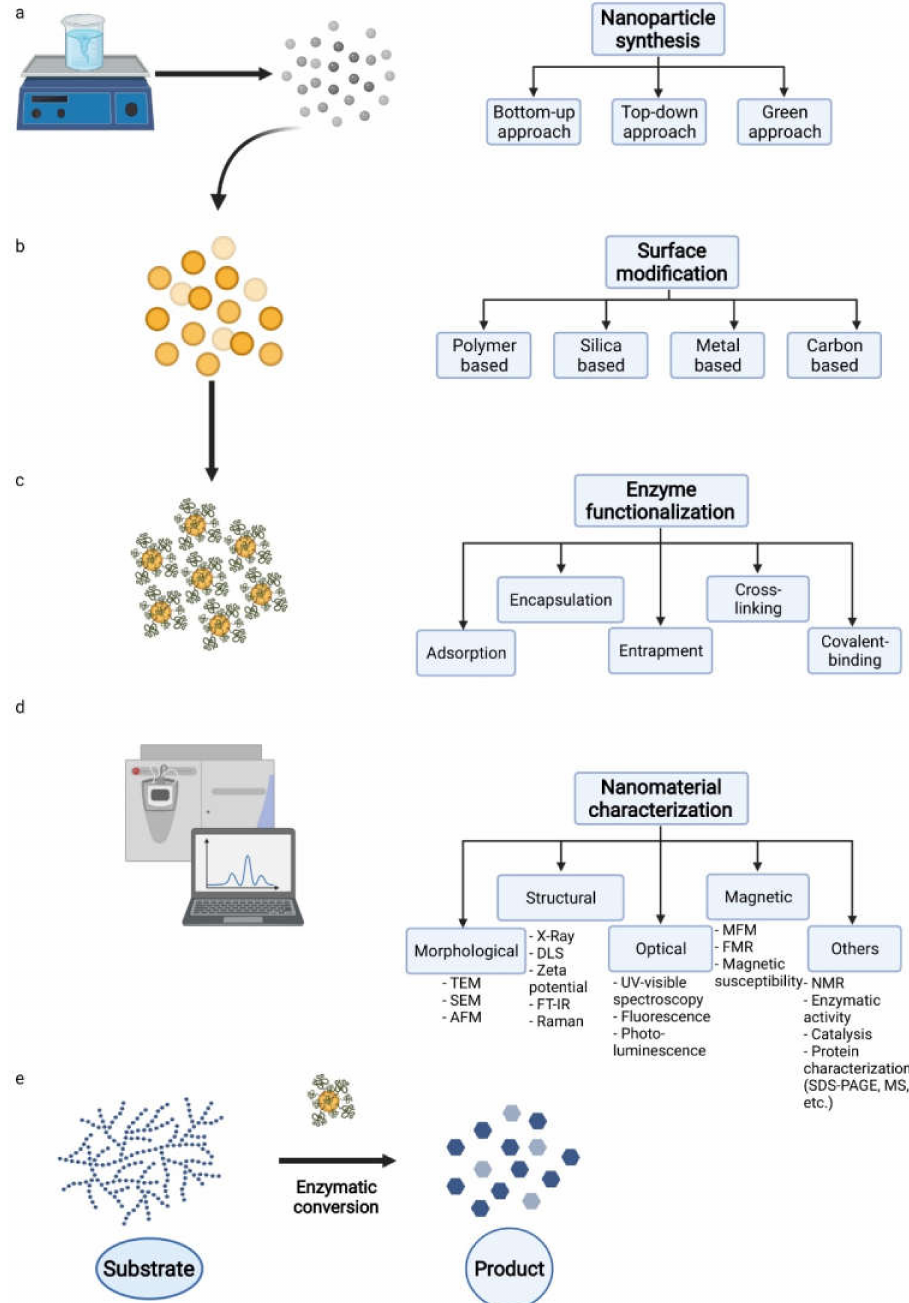
Figure 2. Illustration of the main steps for synthesis ( a – c ), characterization ( d ), and application ( e ) of an immobilized enzyme on a nanomagnet, forming an MNP biocatalyst. The synthesis of this product starts with ( a ) magnetic core synthesis, then ( b ) the best coating substance is chosen for the MNP surface modification for ( c ) suitable functionalization with a target enzyme. In a nanomaterial’s characterization ( d ), it is important to determine the enzyme load and activity. ( e ) The MNP biocatalyst must retain activity toward its substrate in repeated steps after